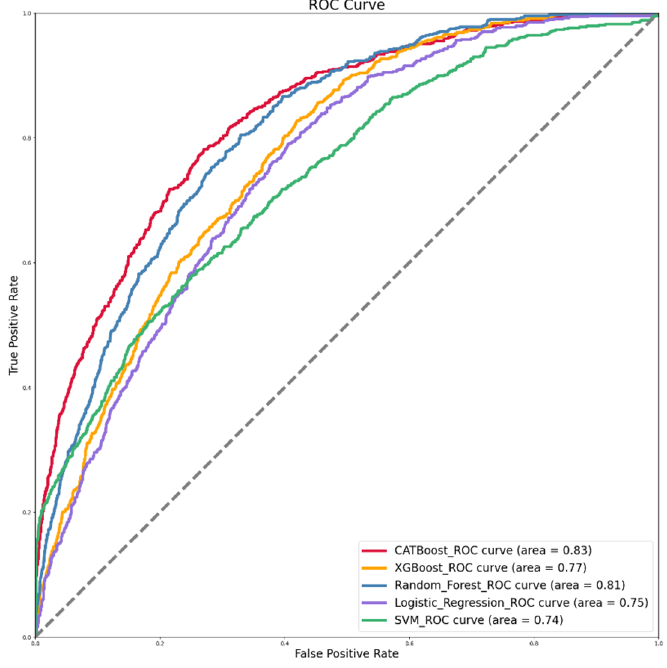
Figure 3. ROC curve figure of five machine-learning